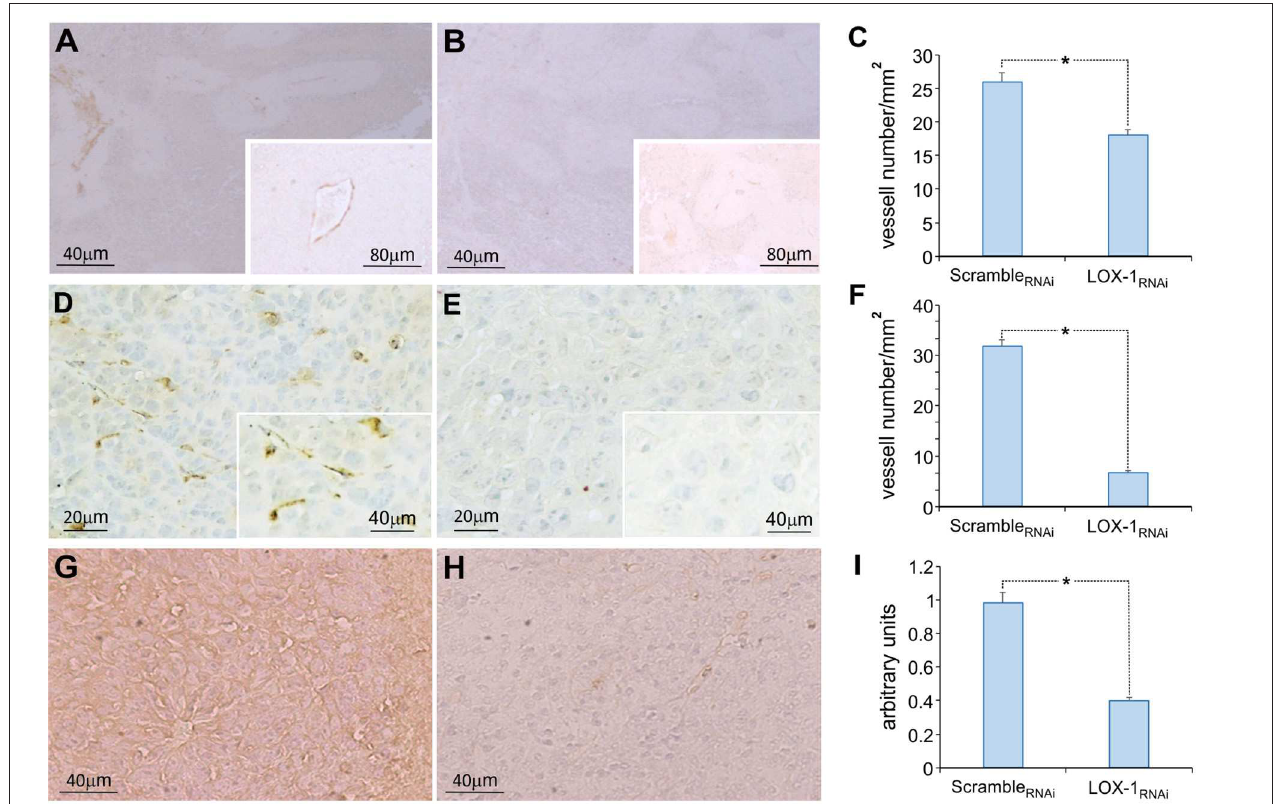
FIGURE 1 | Representative images of the immunohistochemical analysis of α -SMA, CD31, and VEGF-A165 expression in xenograft tumoral tissues of mice injected subcutaneously. Neo vessels evidenced by α -SMA immunohistochemistry in scramble RNAi (A) and in LOX-1 RNAi (B) xenograft tumors. Scale bar 40 µ m. A representative neo vessel in inset (scale bar 80 µ m). (C) Graph showing the number of vessels identified by α -SMA antibody in LOX-1 RNAi , significantly reduced respect to those observed in scramble RNAi xenograft tumors (* P < 0.01). Neo vessels evidenced by CD31 immunohistochemistry in scramble RNAi (D) and in LOX-1 RNAi (E) xenograft tumors. Scale bar 20 µ m. A representative neo vessel in inset (scale bar 40 µ m). Graph showing the number of vessels identified by CD31 antibody in LOX-1 RNAi , significantly reduced respect to those observed in scramble RNAi xenograft tumors (* P < 0.01) (F) . Representative images of the immunohistochemical analysis of VEGF-A165: tumoral mass in scramble RNAi (G) and in LOX-1 RNAi (H) xenograft tumors. Scale bar 40 µ m. Graph representing